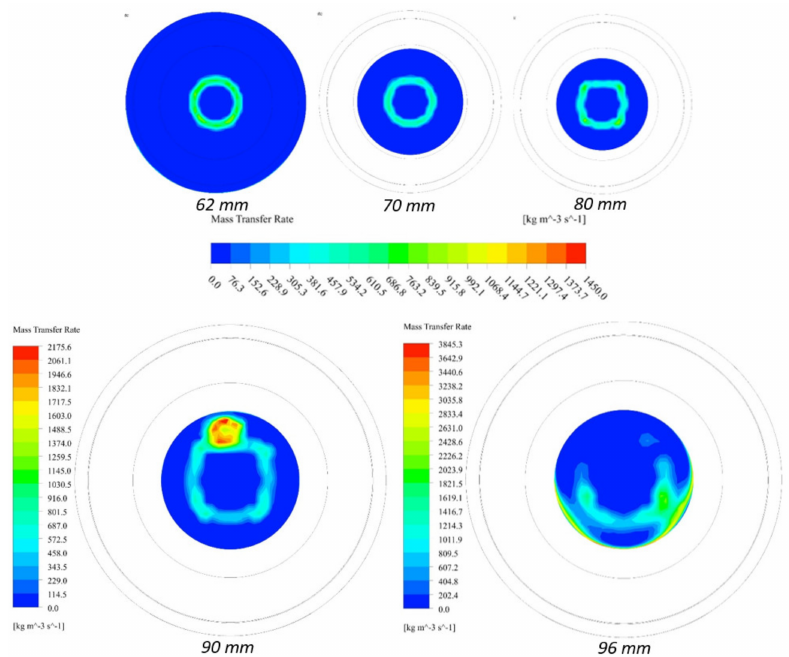
Figure 18. Mass transfer rate for single-nozzle